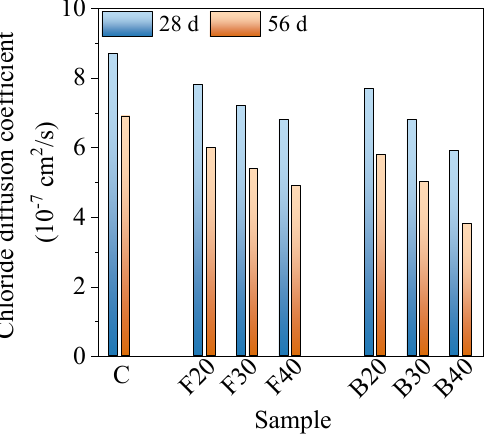
Figure 6. The chloride diffusion coefficients of the concrete containing FA and GGBS under an equal 28-day strength grade.